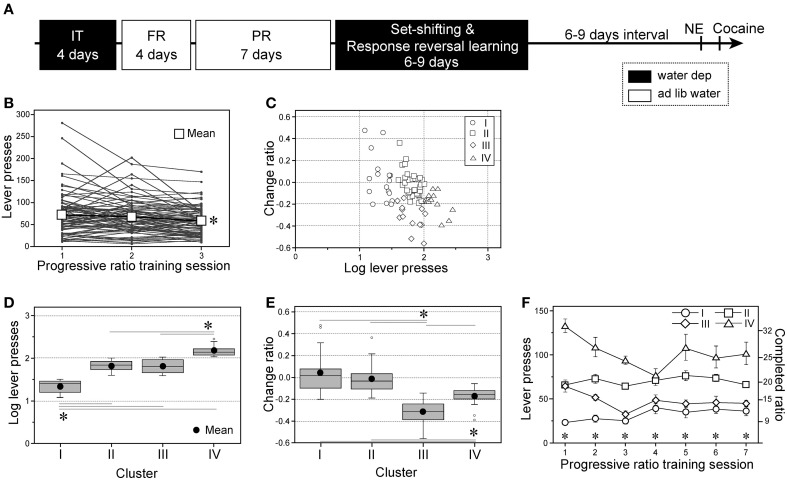
Individual variability in progressive ratio instrumental performance of subgroups. (A) A chronological schema of the entire experimental procedure of Experiment 1. IT, initial instrumental training; FR and PR, fixed- and progressive-ratio instrumental trainings, respectively; NE and cocaine, novel environment- and cocaine-induced behaviors testing, respectively. Black and white boxes = the days with or without water deprivation, respectively. (B) Individual performances with progressive ratio (PR) instrumental training for the first three training sessions. The data of the third session was compared with those of the first and second sessions [session: F(2, 156) = 10.01, p < 0.0001] (C) Each rat's performance plotted on a two-factorial surface. x-axis: number of lever presses in the first PR session normalized by a common logarithm (log) transformation; y-axis: change ratios of lever presses from first (a) to third (b) sessions, (b − a)/(b + a). (D,E) Box plots of the log-transformed lever press numbers during the first PR session; Cluster I, n = 17; II, n = 36; III, n = 13; IV, n = 13 [D, subgroup: F(3, 75) = 106.42, p < 0.0001] and the change ratio [E, subgroup: F(3, 75) = 20.58, p < 0.0001]. (F) Active lever presses during seven PR sessions by four subgroups. Data are shown as subgroup mean ± SEM; Cluster I, n = 13; II, n = 32; III, n = 12; IV, n = 10 [subgroup × session interaction: F(18, 376) = 3.52, p < 0.0001]. *p < 0.05, between sessions (B), between relevant subgroups (D,E), or significant simple-main effects of subgroup on each session (F).